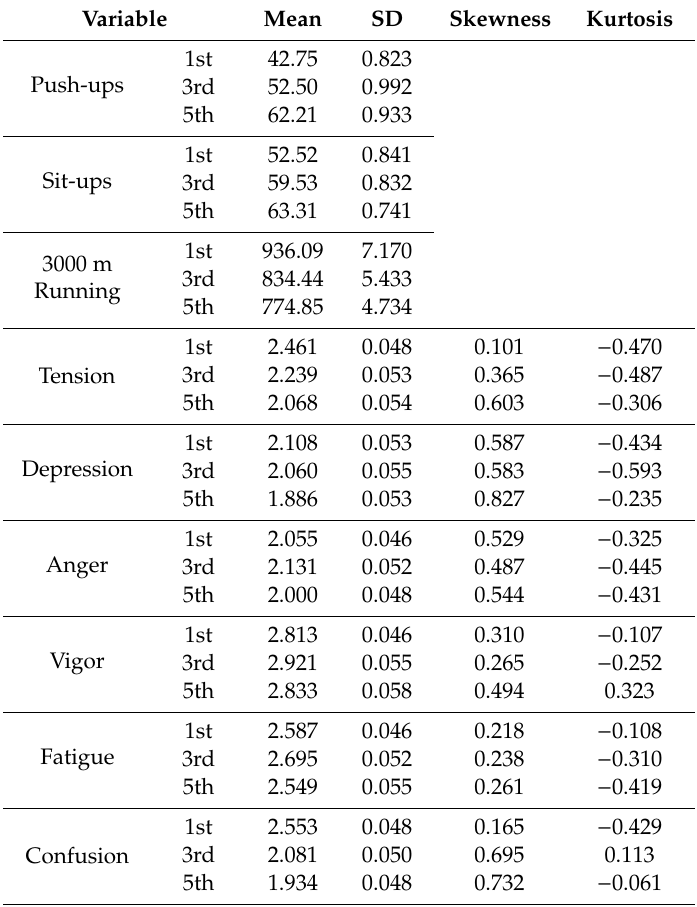
Table 3. Descriptive statistics for each measurement